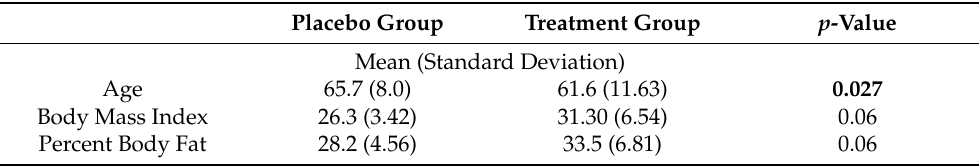
Table 1. Baseline parameters of the study participants.